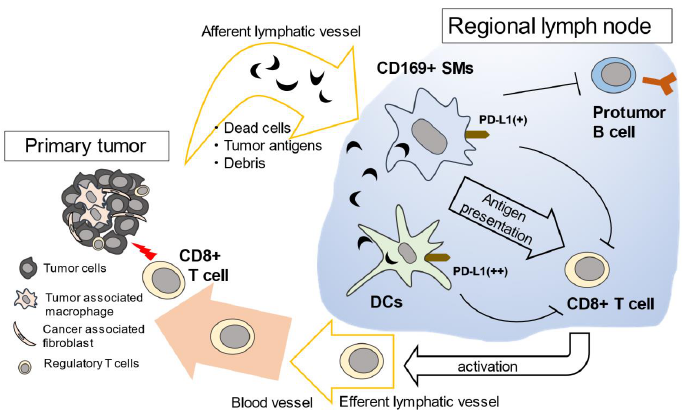
Figure 3. Proposed model of the function of CD169 + SMs in anti-tumor immunity. Dead tumor cells and debris are delivered to draining lymph nodes via lymphatic vessels. CD169 + LySMs in the regional lymph nodes capture dead tumor cells and present the tumor antigens to CD8 + T cells. SMs are also thought to suppress the proliferation of pro-tumor B cells. DCs capture tumor antigens passed through by SMs and activate tumor-specific CD8 + T cells, subsequently activated CD8 + T cells travel to the tumor microenvironment. Since both SMs and DCs express PD-L1, it is thought that anti-tumor immune reactions in the lymph nodes could be activated by anti-PD1/PD-L1 therapy.